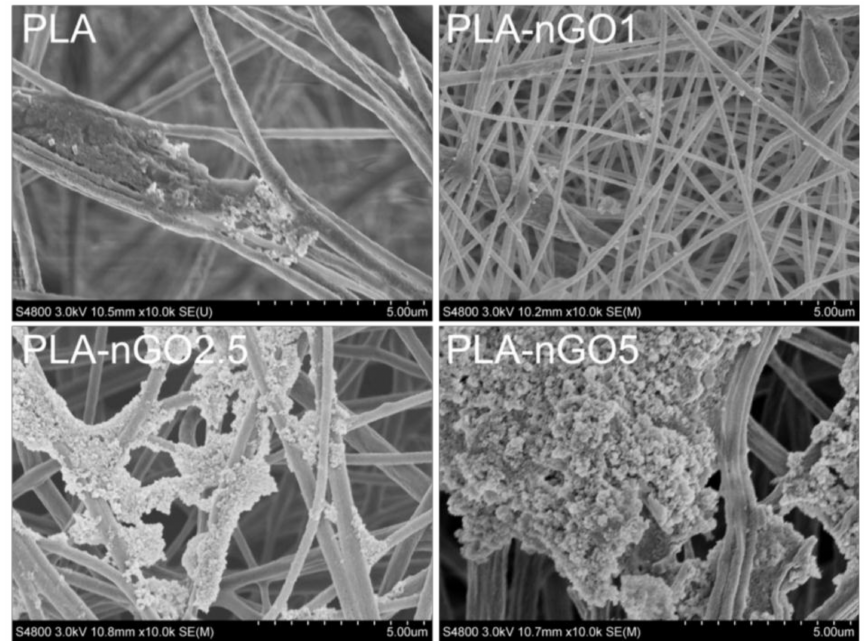
Figure 7. SEM images of PLA, PLA-nGO1, PLA-nGO2.5, and PLA-nGO5 fibers after 24 days of mineralization in